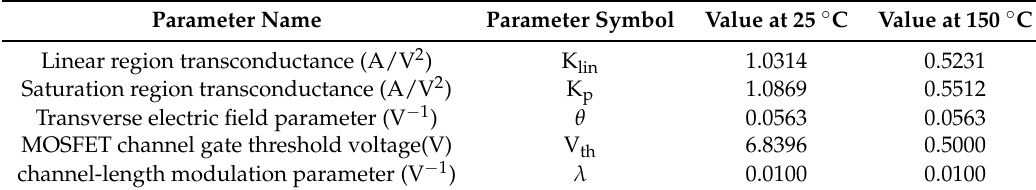
Table 3. MOSFET model parameters.